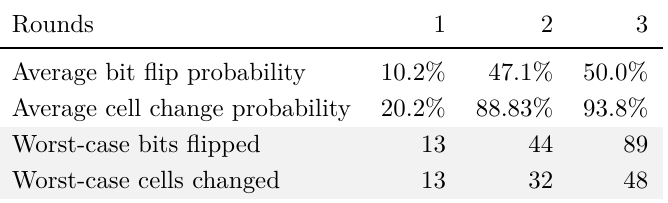
Table 2: Avalanche test flipping a single bit.